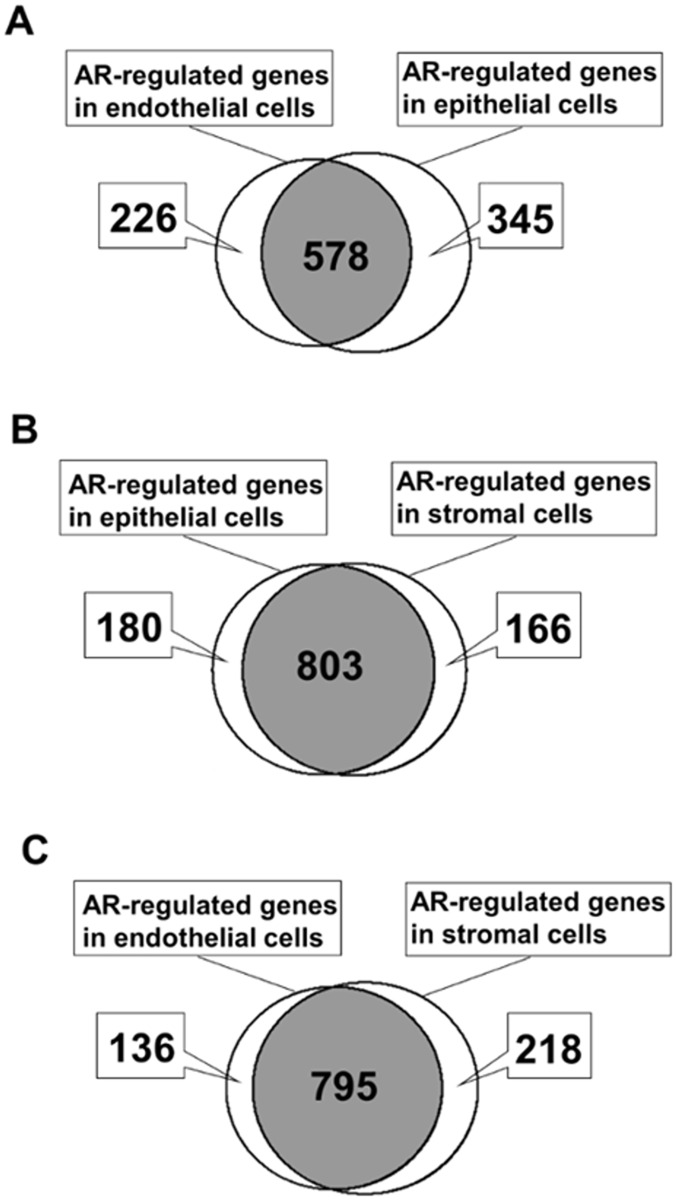
AR-regulated gene expression.Venn diagram of differential expression of 1149 AR-regulated genes between endothelial cells vs epithelial cells (A), epithelial cells vs stromal cells (B), and endothelial cells vs stromal cells (C).